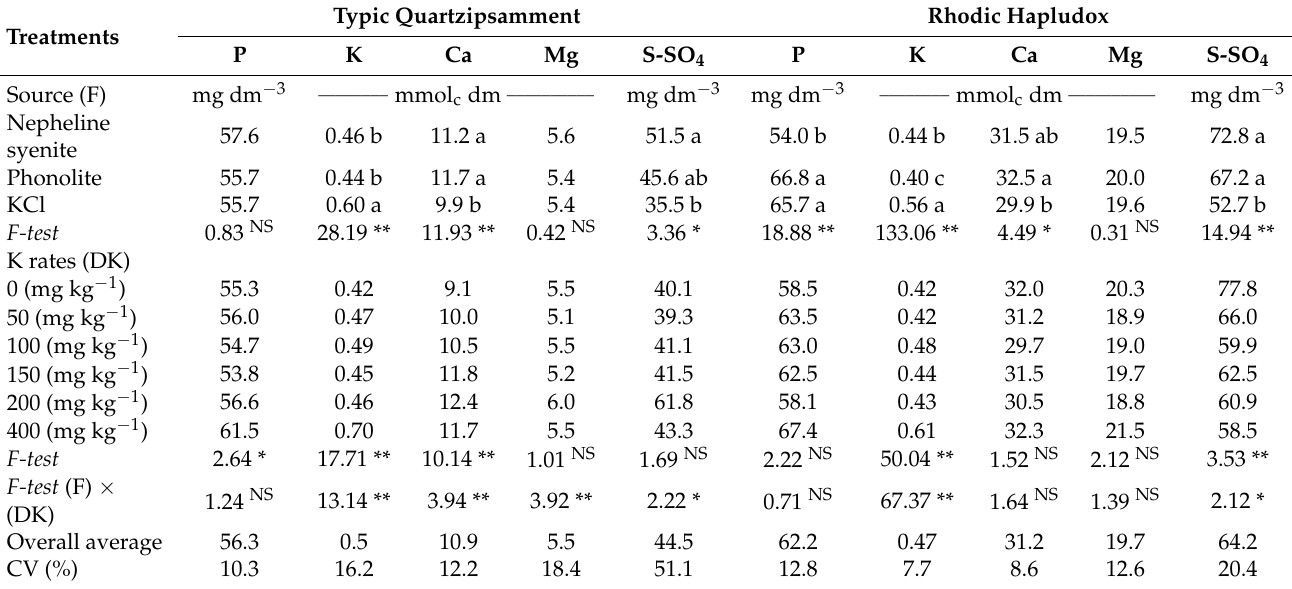
Table 6. Effect of treatments on macronutrient concentrations after maize cultivation in the Typic Quartzipsamment, and in the Rhodic Hapludox, depending on the application of potassium sources and